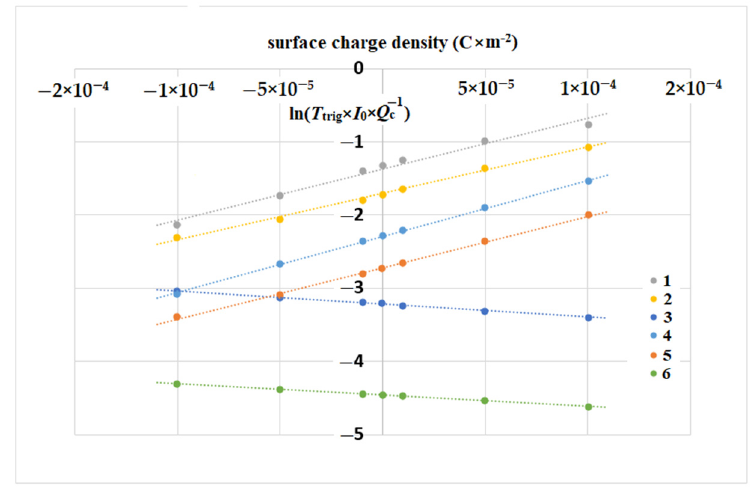
Figure 4. The dependence of normalized triggering time on the surface charge density Q s , target Si and GaAs, p -type. U ct = 0.5 V, U an = 1 V, U g = 3 V. The dopant concentration, [cm − 3 ], equal for p-Si: ( 1 ) 10 12 ; ( 2 ) 10 14 ; ( 3 ) 10 16 ; and for p-GaAs: ( 4 ) 10 12 ; ( 5 ) 10 14 ; ( 6 ) 10 16 .